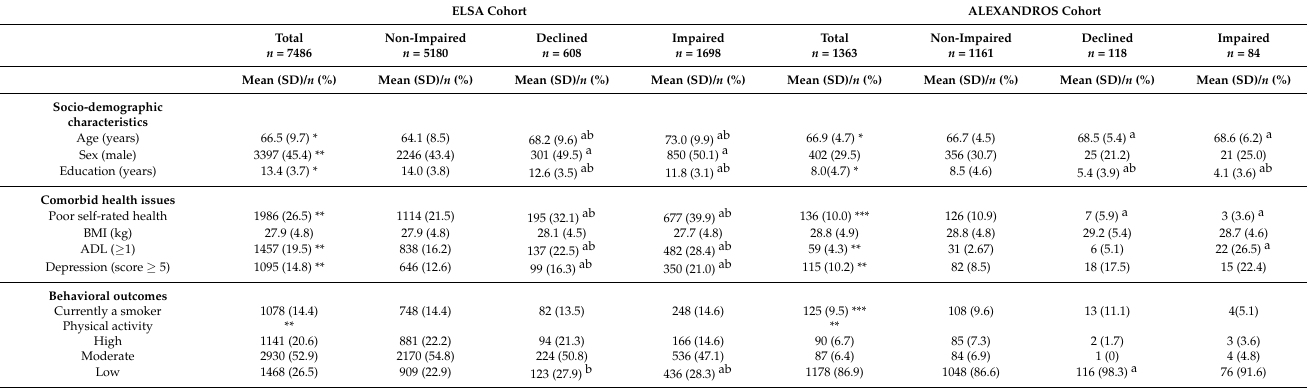
Table 1. Baseline sample characteristics of ELSA and ALEXANDROS